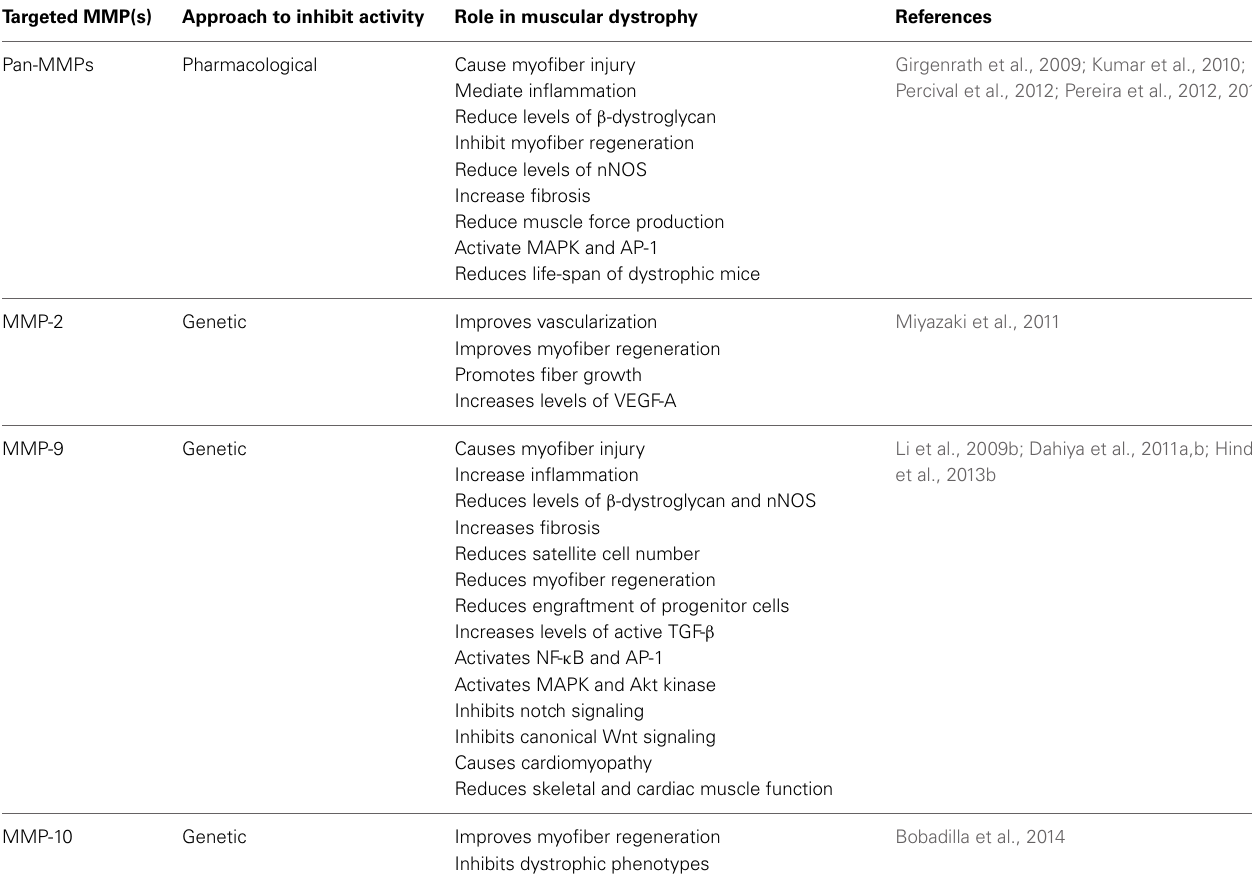
Table 1 | Role of different MMPs in muscular dystrophy studied by pharmacological or genetic